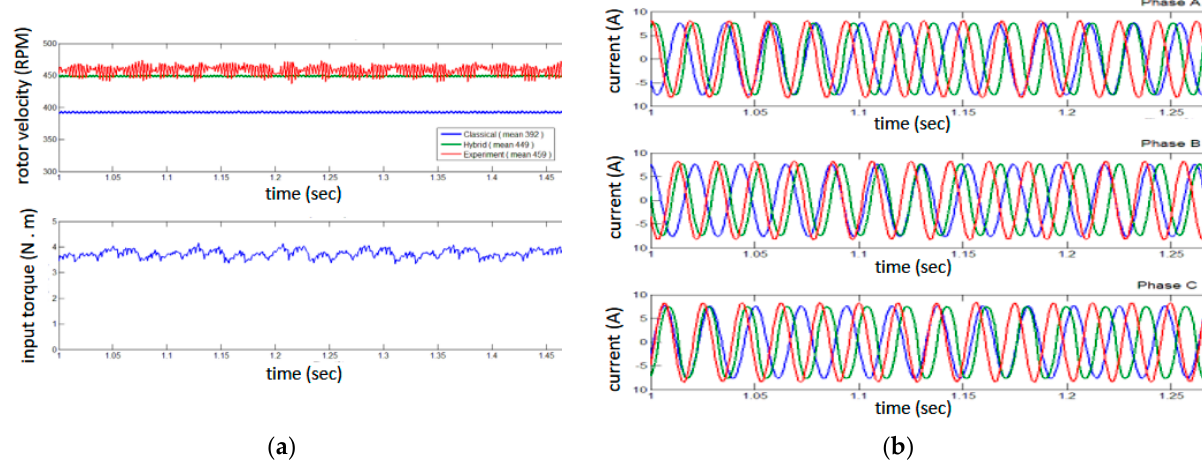
Figure 10. Full-speed steady state response, showing ( a ) the rotor velocity and input torque and ( b ) a comparison of the stator currents. The plots show a comparison of the classical model (blue trace), hybrid model (green) and experimental measurements (red).